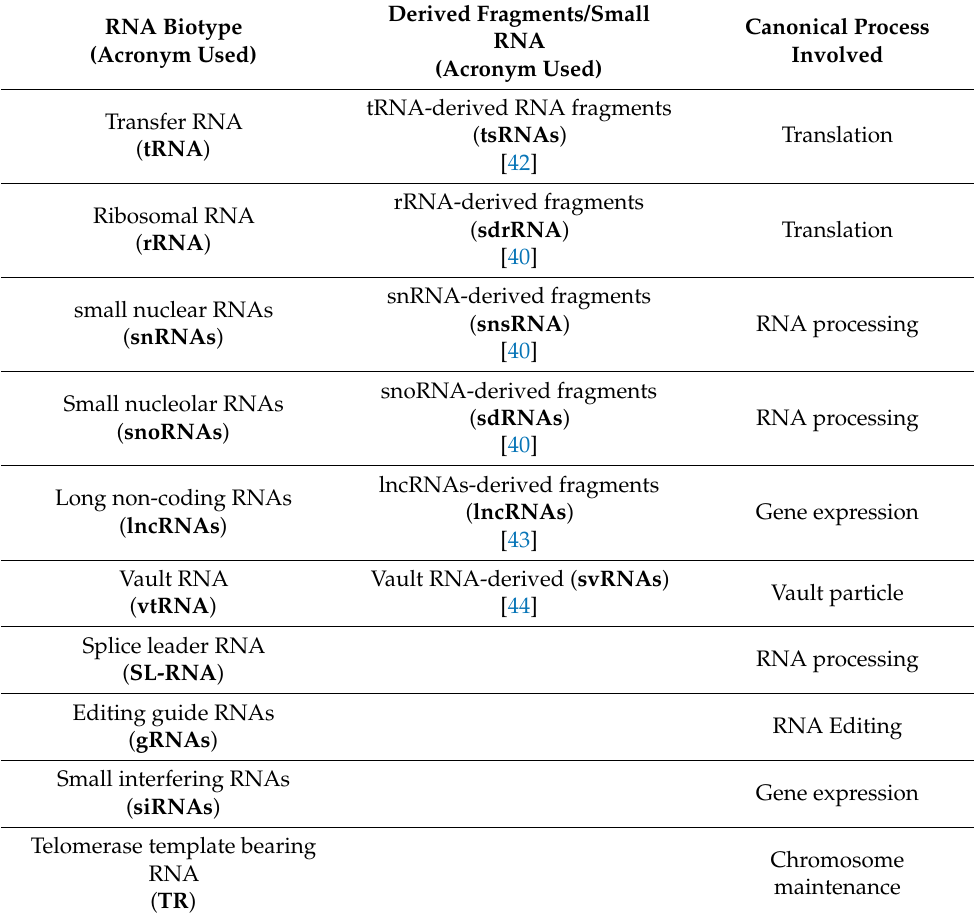
Table 1. Standardized names for the ncRNAs and derived